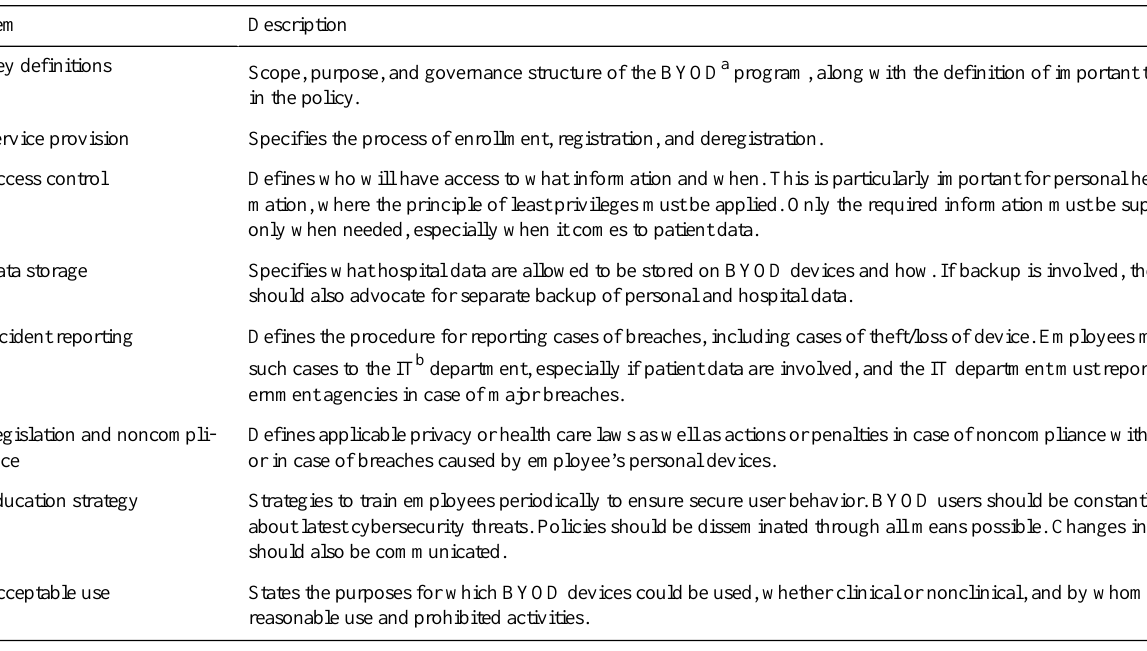
Table 2. Key elements of a hospital’s bring-your-own-device